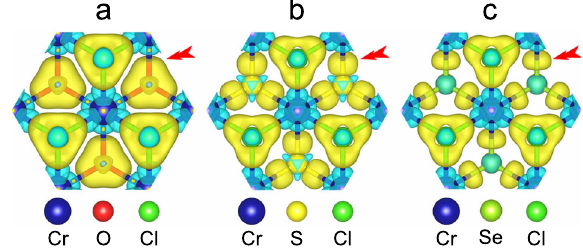
Fig. 5 Evolution of J ex U d = 5